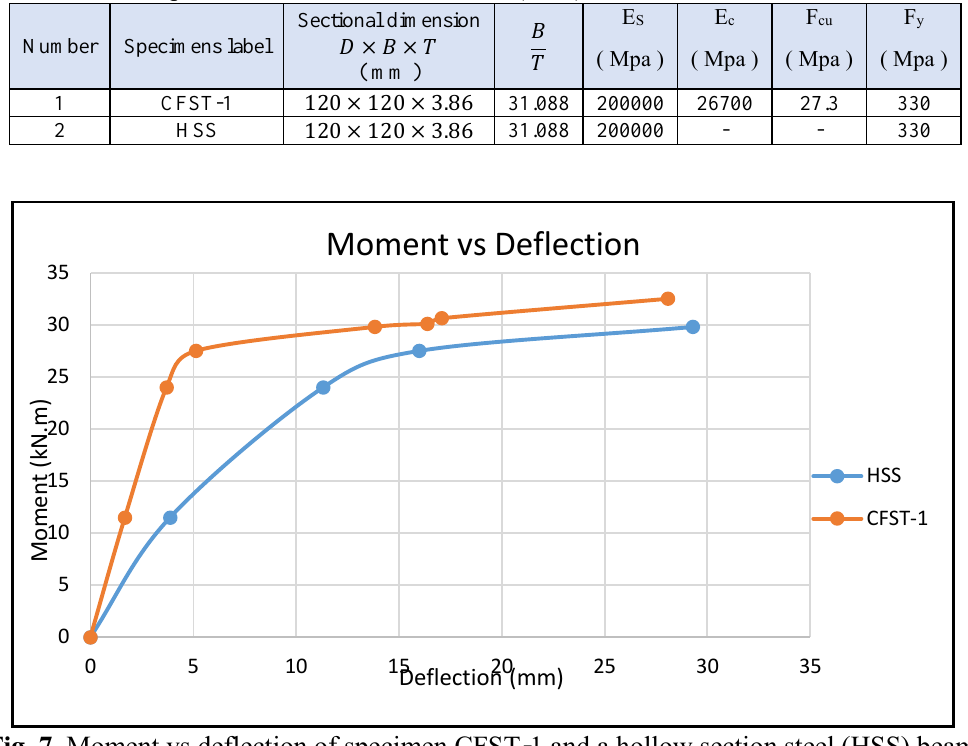
Fig. 7. Moment vs deflection of specimen CFST-1 and a hollow section steel (HSS)